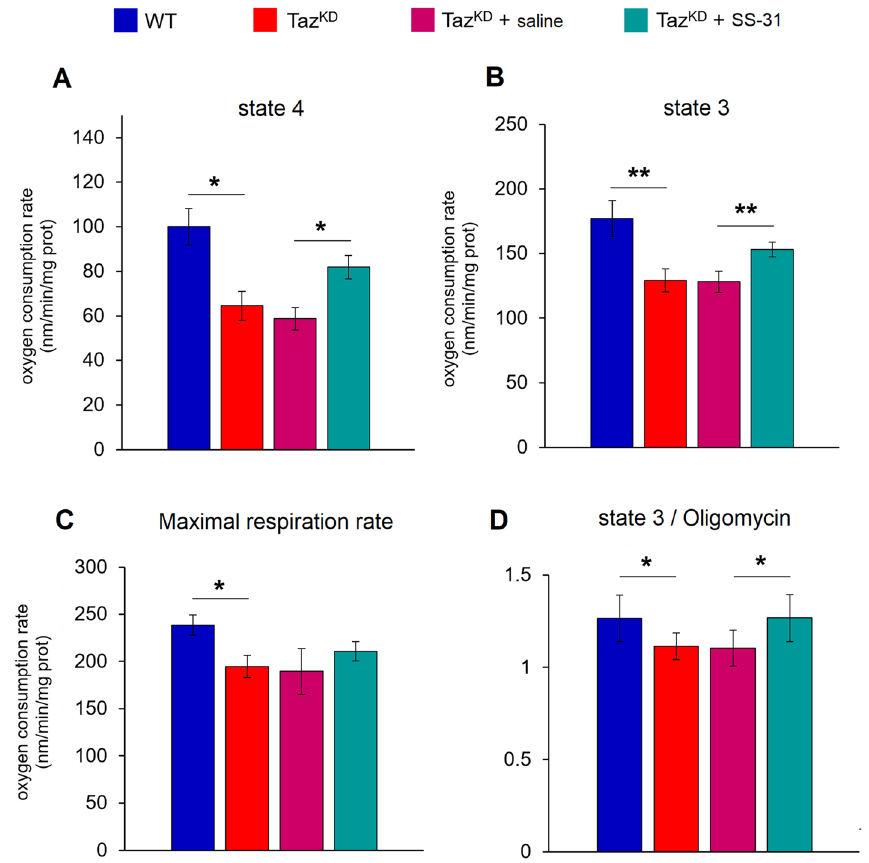
Figure 4. Cardiac mitochondria respiratory rates and effect of SS-31. The oxygen consumption rate of non- phosphorylating (state 4) ( A ) and phosphorylating (state 3) ( B ) with succinate as respiratory substrate. Full uncoupling of the succinate-dependent respiration rate was assessed in the presence of 0.25 μM CCCP ( C ). The respiratory control ratio (RCR) was calculated by the state 3/post-oligomycin respiration ratio ( D ). Histograms display the mean values ± SD (n = 4/group). Statistically significant differences are indicated: Student’s t-test (**p < 0.01, *p <